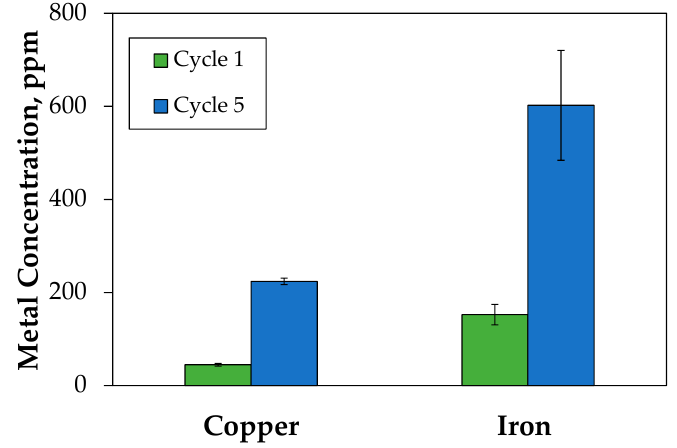
Figure 5. Leaching of tailing with different dissolution cycles. Contact time per cycle of 4 h and 500 rpm.